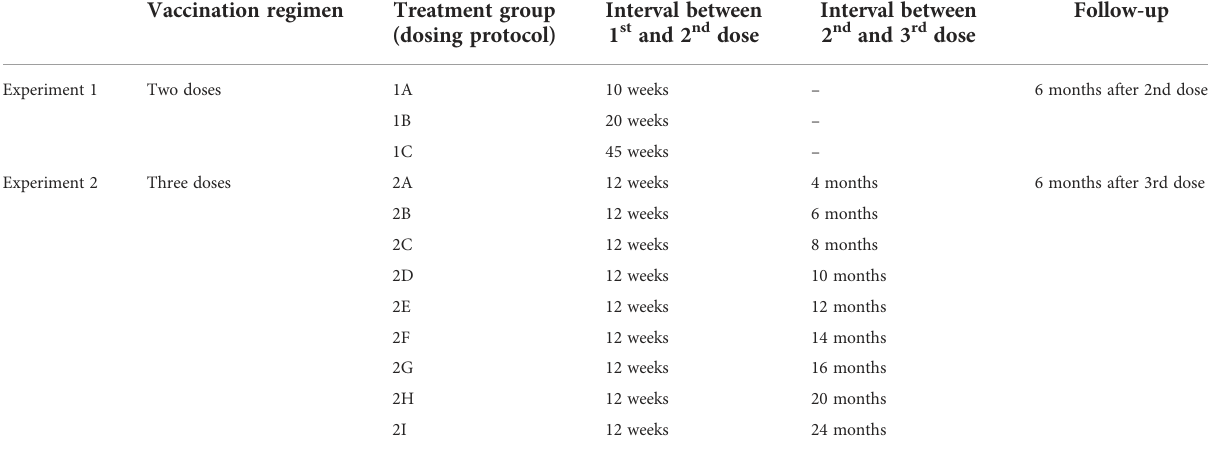
TABLE 1 In-silico vaccination